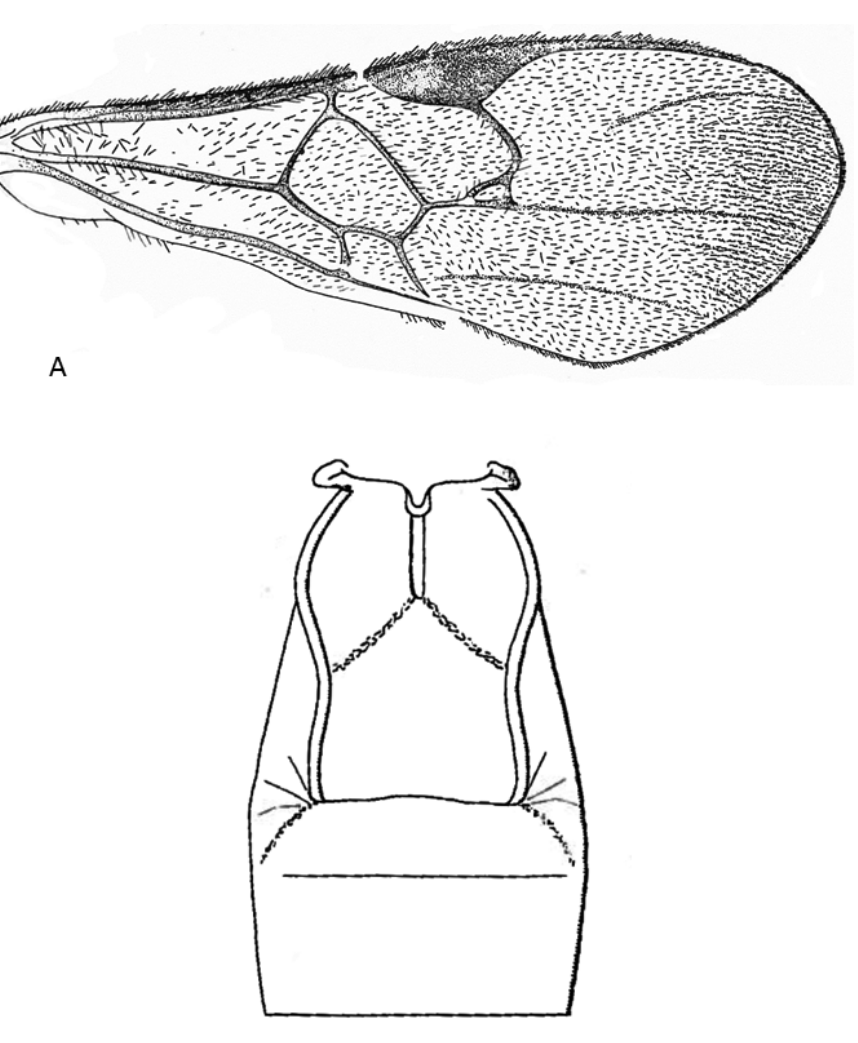
Figure 40. Ypsilonigaster bumbana holotype based on modified drawings from the original descriptions of the species (de Saeger 1942). A Fore wing B Tergites 1 to 3. Ypsilonigaster naturalis Fernandez-Triana & Boudreault, sp. n. http://zoobank.org/FC36191B-29DE-421E-8A43-B6E486348290 Fig. 41 Holotype. Female, Malaysia, RMNH. Holotype labels. MALAYSIA: SE.SABAH /nr Danum Valley Field C./WON1, Mal. trap 5, c.150m/5–26.x.1987, RMNH’87/C.v.Achterberg &D.Kennedy. Second label: